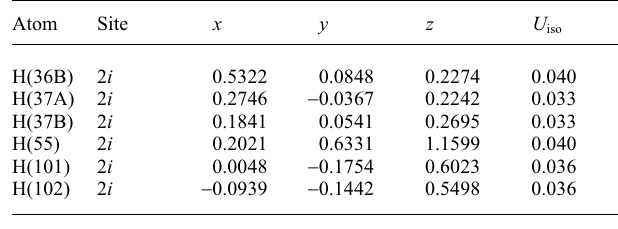
Table 3. Atomic coordinates and displacement parameters (in Å 2 )